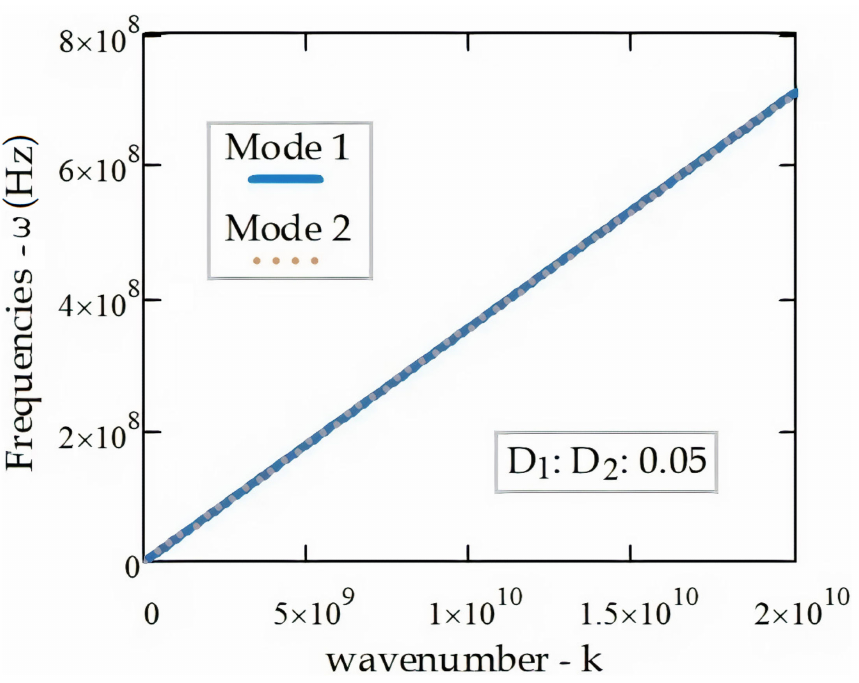
Figure 2. EM wave dispersion relation (k, ω ) in the